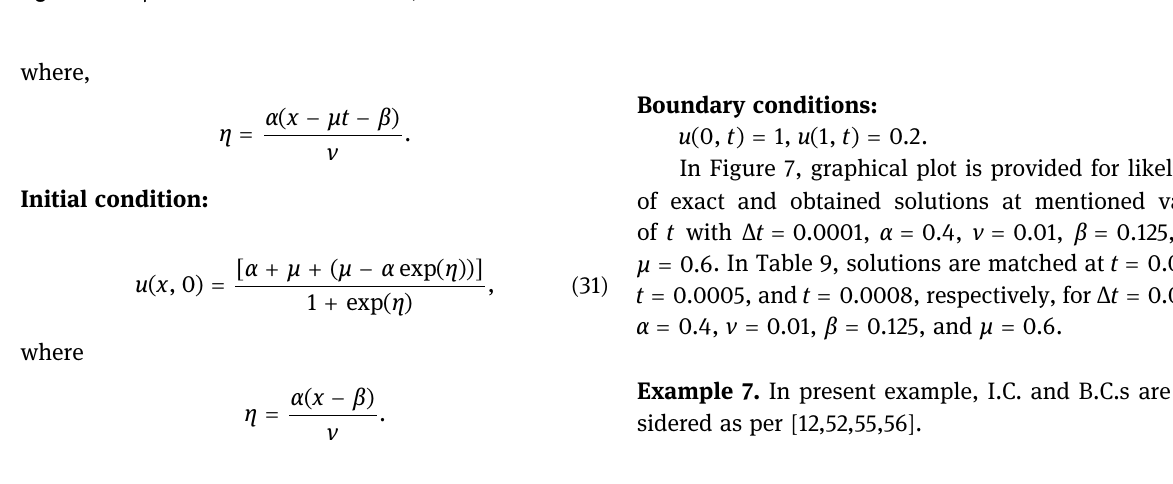
Figure 3: Comparison of solutions for = N 21 , = t Δ 0.0002 and = ν 0.00006666 .